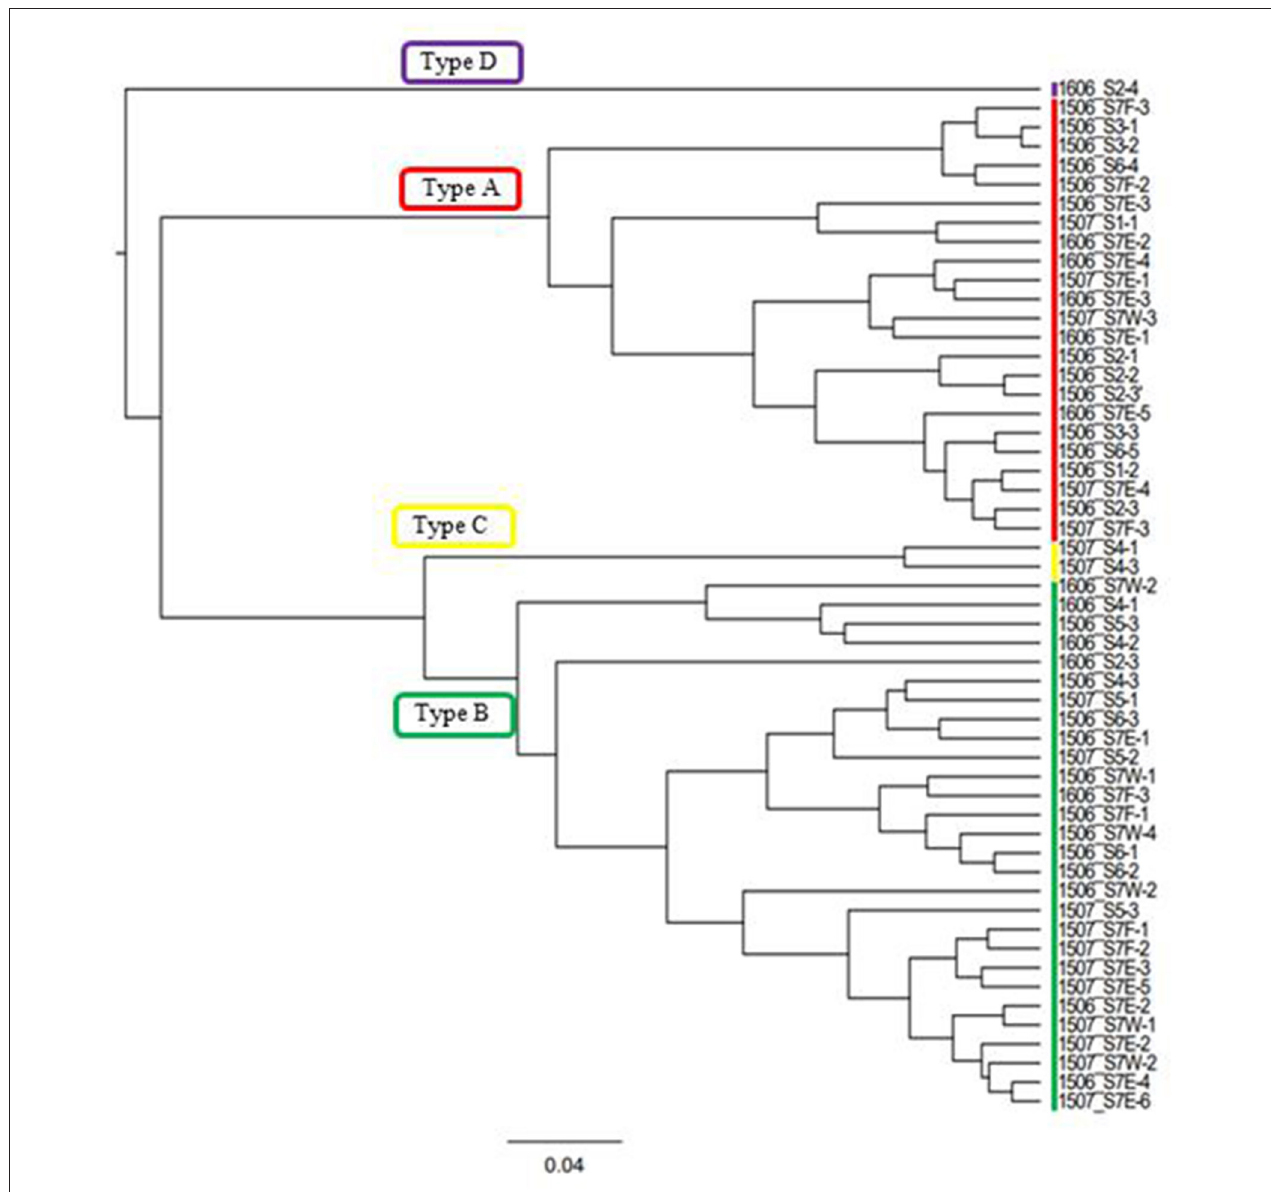
FIGURE 5 | Cluster analysis performed based on the algal pigment composition of red snow samples. Four groups classified in this study based on the result were shown (Types A, B, C, and